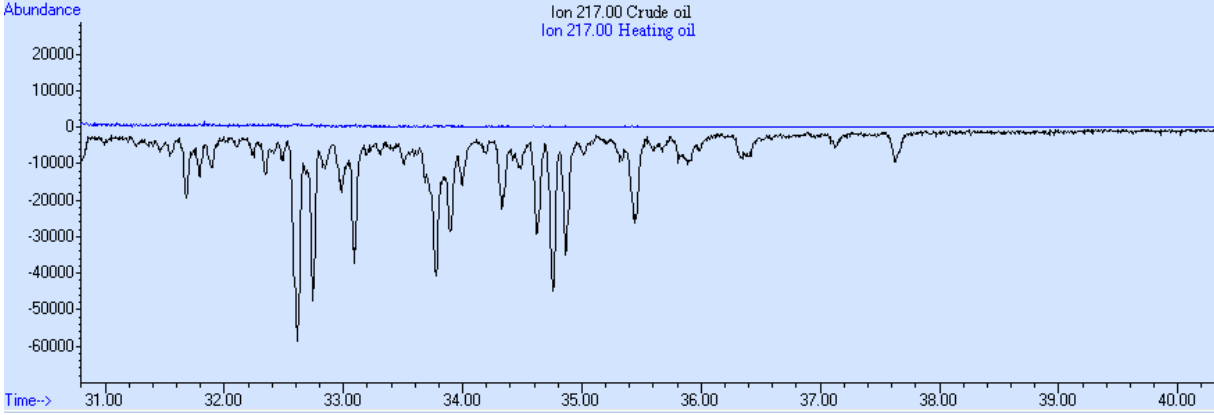
Figure 5. Comparison of EIC at m/z 191 between crude oil and banker oil samples.